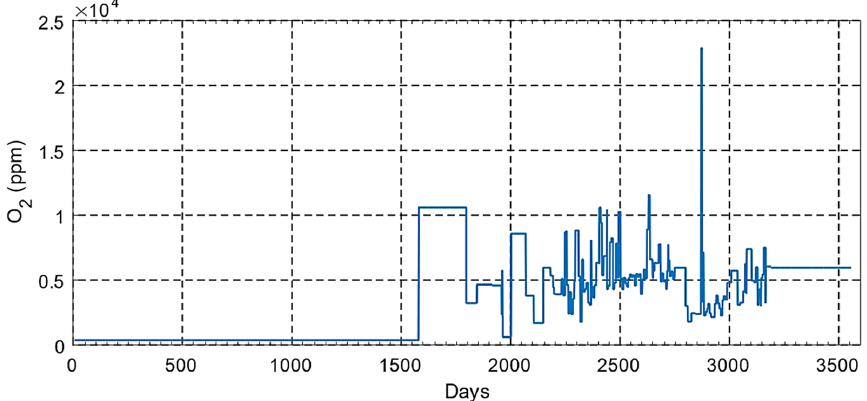
Figure 49. Evolution of interpolated oxygen concentration for online data.